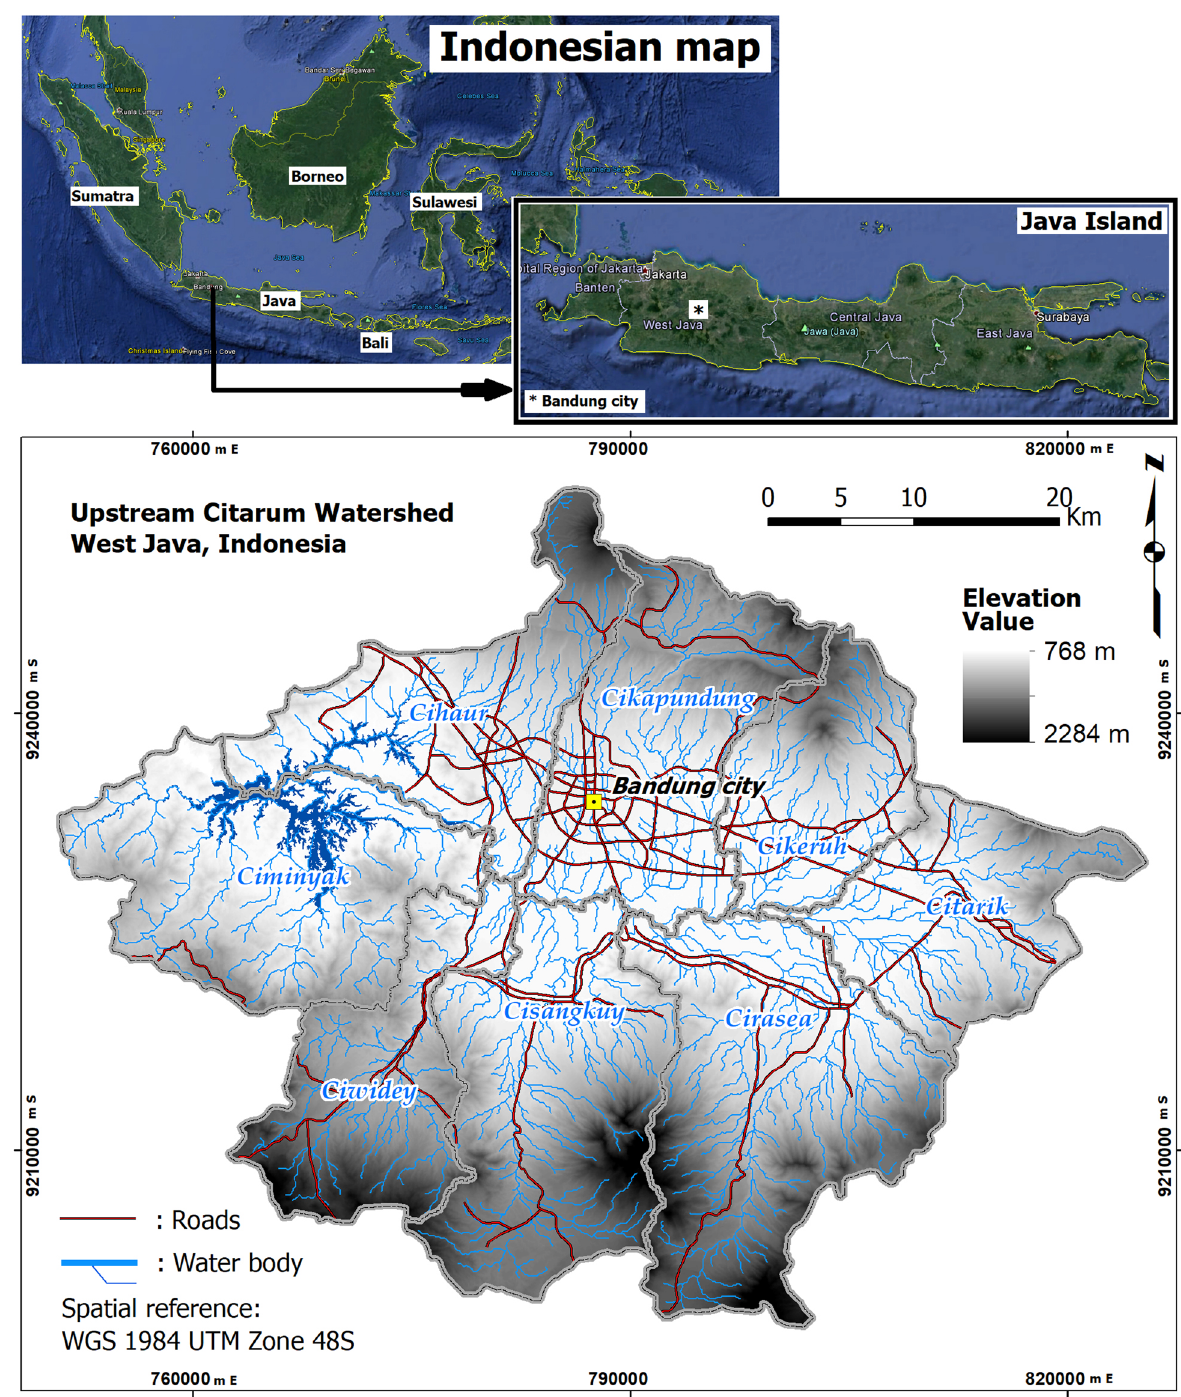
Fig. 1. Study area at the upstream Citarum Watershed, West Java, Indonesia. Elevation value from SRTM30 DEM provided by the U.S. Geological Survey